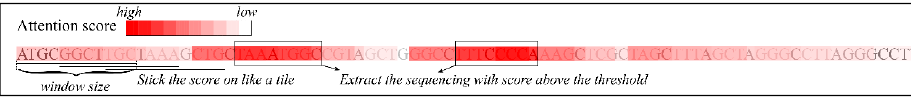
Figure 4. Illustrations of extraction of high-attention sequence